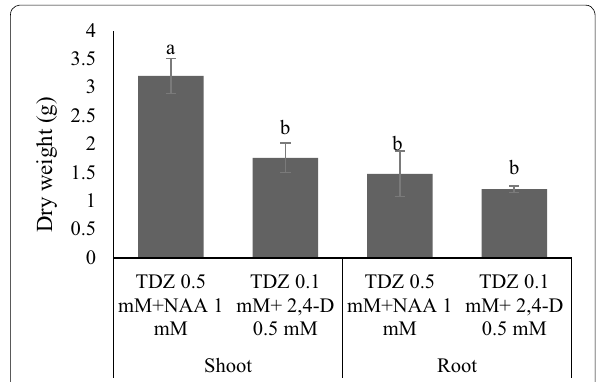
Fig. 2 Effect of hormone and explant on cell dry weight (g) of feverfew cell suspension culture. Means with different letters were significantly different according to the LSD